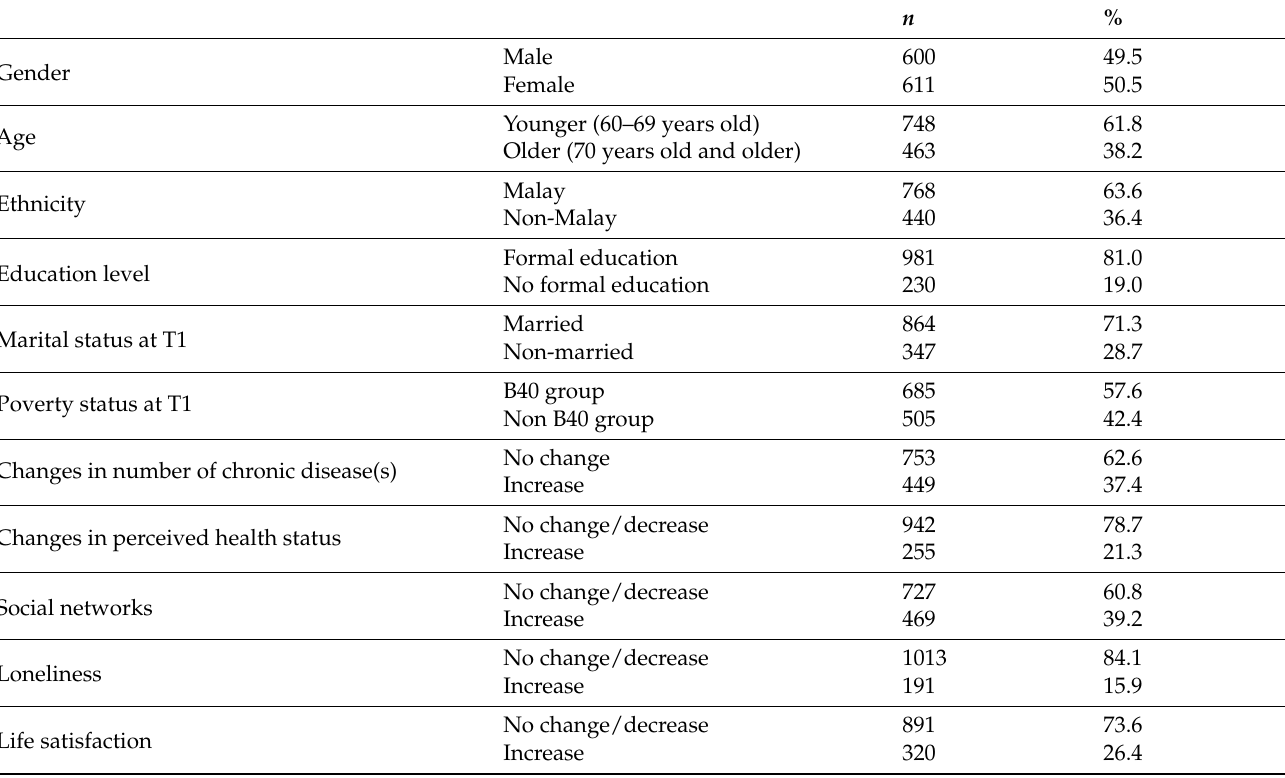
Table 1. Background characteristics of the sample ( n = 1211).